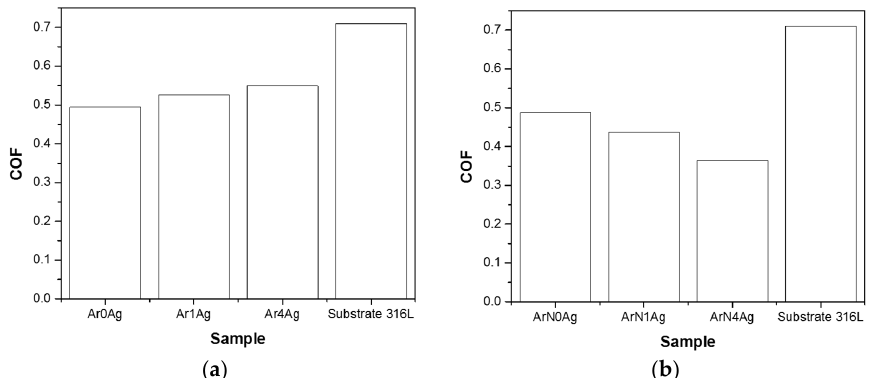
Figure 7. Values of coefficient of friction (COF) of the deposited coatings: ( a ) inert atmosphere; ( b ) reactive atmosphere.